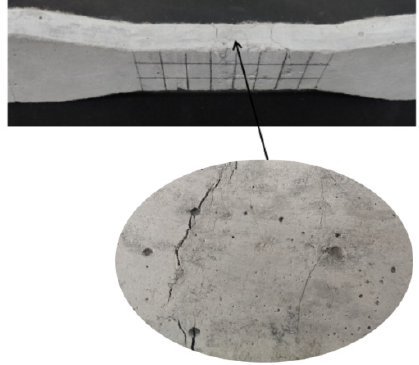
Figure 2. Cracks of ECC specimen.